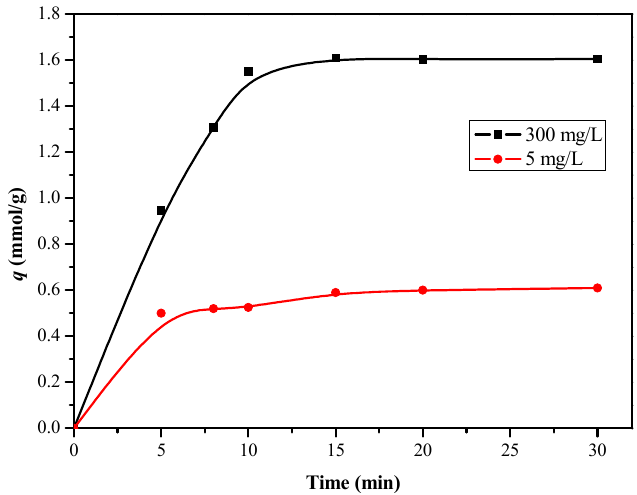
ff ect of time on boron uptake of PSF-diol membrane (pH = 8.0, T = 25 ◦ Figure 12. Effect of time on boron uptake of PSF-diol membrane (pH = 8.0, T = 25 °C). Figure 12. E